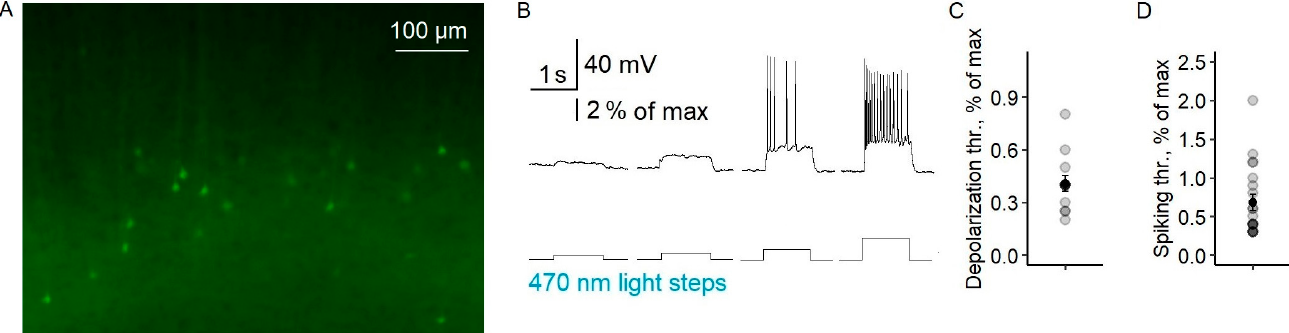
Figure 2. The electrophysiological properties of ChR2-expressing neurons (Model 1) . ( A ) Microphotography of the deep layers of the entorhinal cortex. ( B ) A representative example of the responses of a pyramidal neuron to light steps with different intensities. Depolarization ( C ) and spiking ( D ) threshold LI in pyramidal cells. Circles are individual values, small black circles are mean values, and whiskers are standard errors of the means. Light intensity was calculated in percentages of the maximal value of LED.